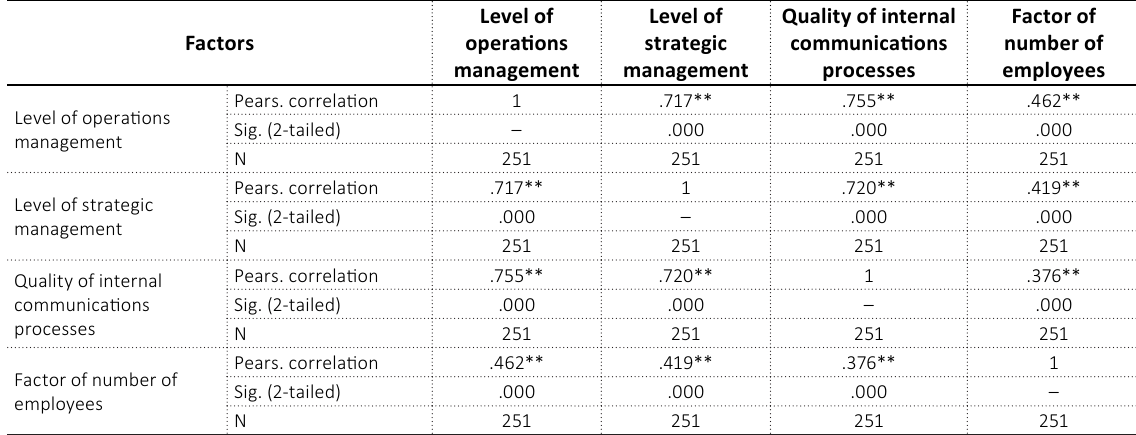
Table 8. Correlation analysis of the level of management of selected internal communication processes